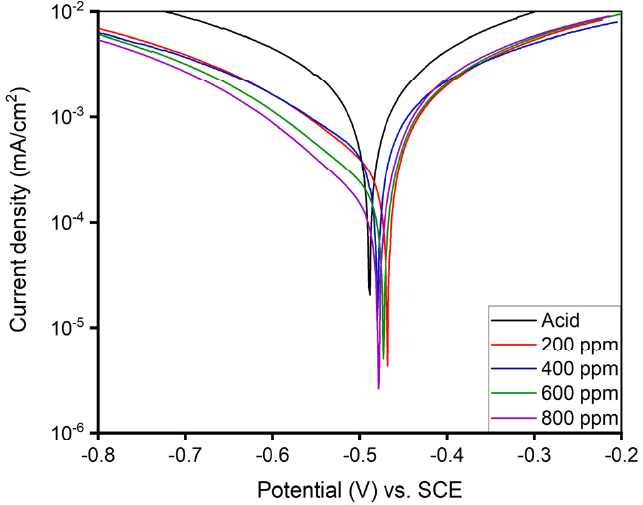
Figure 11. PDP curve for as-immersion of MS sample in 1 M H 2 SO 4 solution with and without different concentrations of alkaloid extracted from AA at 293 K.